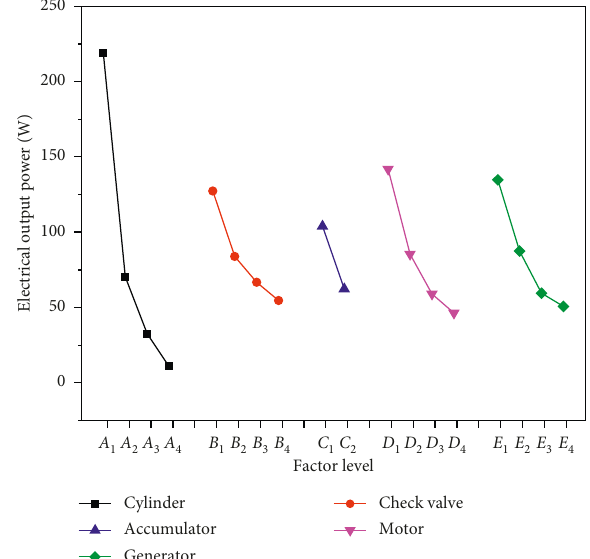
Figure 6: The index level of shaft speed at different factors.